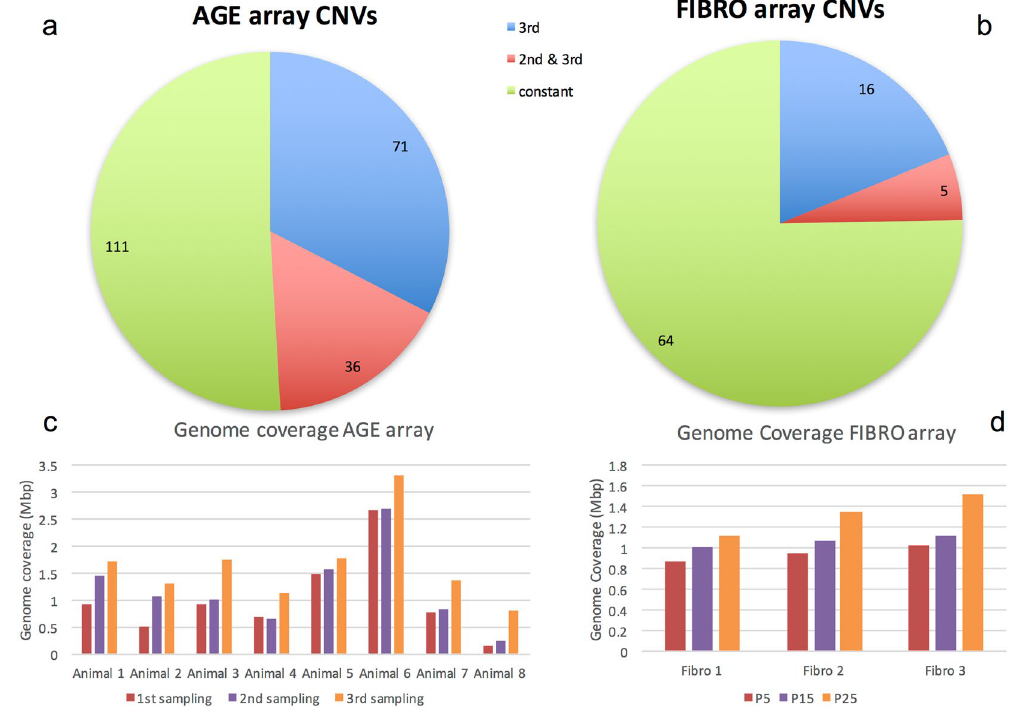
Figure 1. Pie charts presenting the total number of CNVs identified as “constant”, “2nd & 3rd” time point or “3rd” sampling. These latter two classes were scored as “ de novo ”. The ratio of de novo vs. constant CNVs was significantly different between AGE ( a ) and FIBRO ( b ) (p < 0.0001). Genome coverage of AGE array samples ( c ) and FIBRO array samples ( d ) at the three time points. Cumulative increase of the portion of genome involved in CNVs are visible as de novo CNVs added to the constant CNVs over